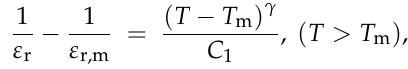
Table 2. Compilation of temperature of maximum permittivity ( T m ), maximum relative permittivity ( ε r,m ), loss factor at T m ( tan δ m ), critical exponent ( γ ) and empirical parameter ( ∆ T 18-6.5 with different additives (measured at 1